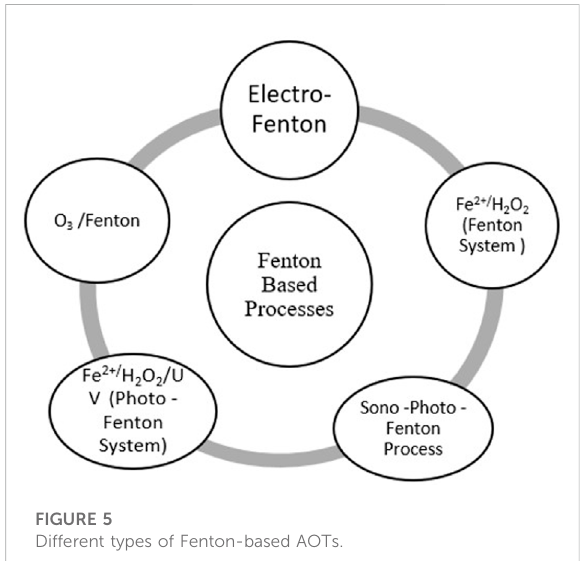
FIGURE 5 Different types of Fenton-based